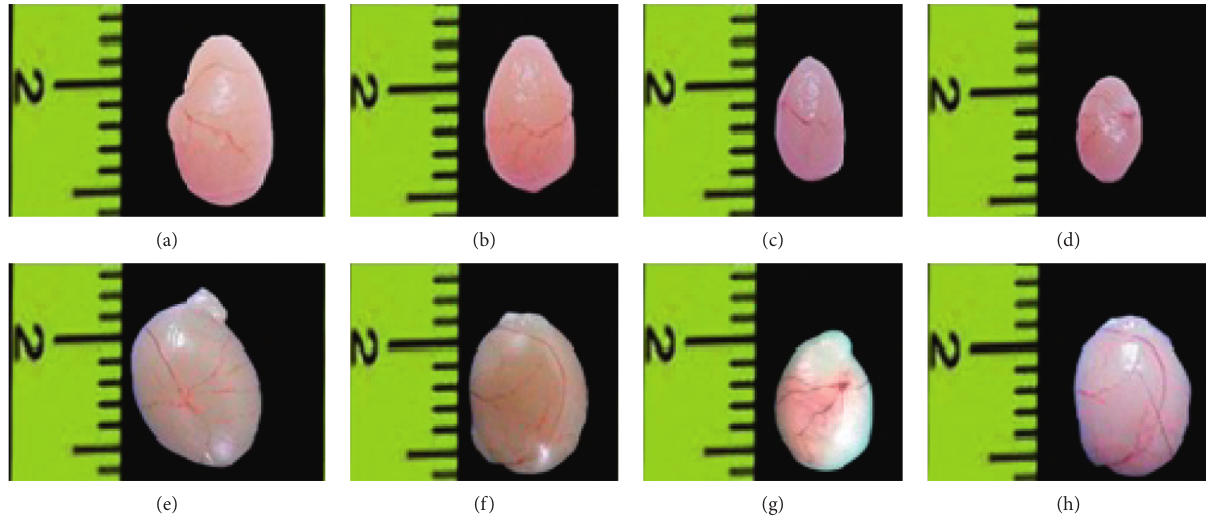
Figure 3: Size of testis in mice exposed to baicalein (BC) without or with testosterone (T) injection. (a) and (e) Control. (b), (c), and (d) 30, 60, and 90mg · BC/kg body weight (BW) exposed F1 males, respectively; (f), (g), and (h) 30, 60, and 90mg · BC/kg BW exposed F1 males administered with 4.16mg · T/kg BW, respectively.